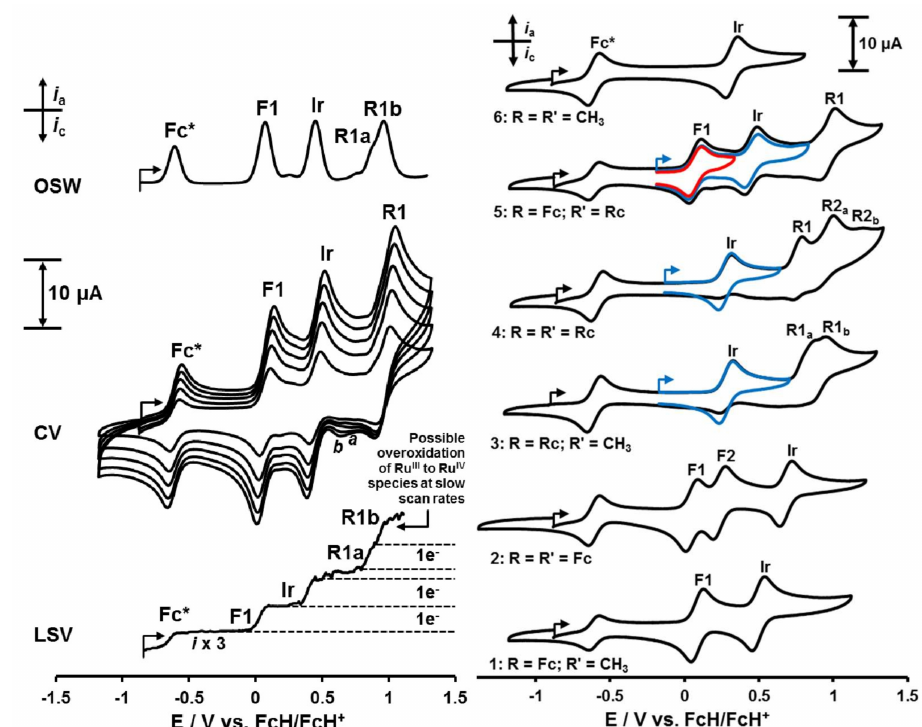
Figure 3. Left , Top: OSW (Osteryoung Square Wave) voltammogram of 0.5 mmol · dm − 3 solutions of [(ppy) 2 Ir(FcCOCHCORc)], 5, in CH 2 Cl 2 (20 o C) at 10 Hz in the presence of Fc* = decamethylferrocene as internal standard. Left , Middle: Cyclic voltammograms at scan rates 0.1 (smallest currents), 0.2, 0.3, 0.4 and 0.5 V · s − 1 (largest current). Left , Bottom: LSV (Linear Sweep Voltammogram) at 2 mV · s − 1 . The ferrocenyl-, iridium- and ruthenocenyl-based redox processes are labelled as F1, Ir and R1 respectively. The small CV reduction peaks labeled “a” and “b” may be associated with either the presence of a Ru IV species, or more likely a dimeric Ru III ruthenocenium species [43]. Likewise, the LSV peak R1b counting 1 electron is consistent with Ru IV formation on LSV timescale. Right : Cyclic voltammograms of ca. 0.5 mmol · dm − 3 solutions of [(ppy) 2 Ir(RCOCHCOR (cid:48) )] complexes 1 – 6 , scanned at 100 mV · s − 1 in CH 2 Cl 2 at 20 o C in the presence of 0.1 mol · dm − 3 [N( n Bu) 4 ][B(C 6 F 5 ) 4 ] as supporting electrolyte. Decamethylferrocene, Fc*, was used as internal reference, it is identified by the wave at -0.608 V vs. FvH / FcH + . Blue and red inserts: CV scans of 3, 4 and 5 where scan directions are reversed before ruthenocene oxidation